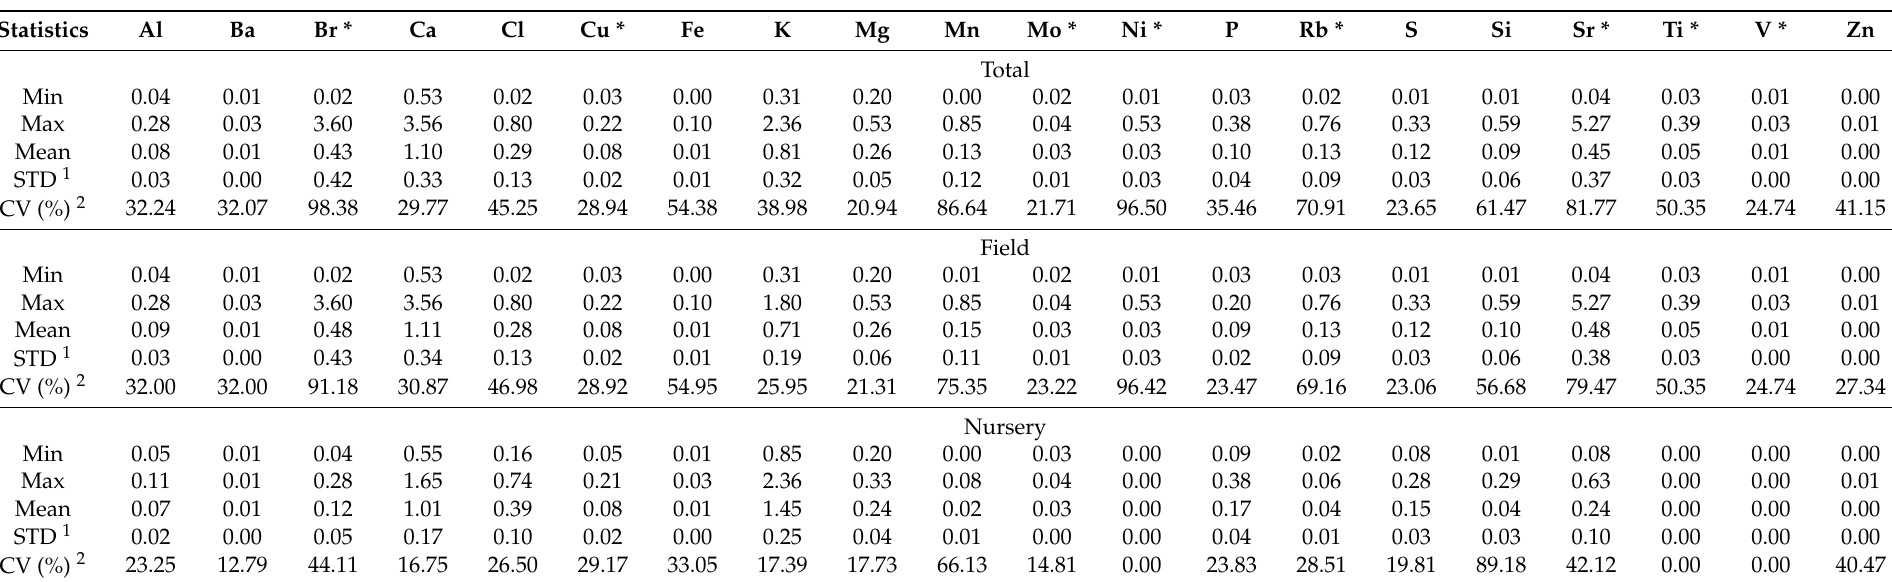
Table 2. Descriptive statistics of portable X-ray fluorescence (pXRF) elemental data (%) of Eucalyptus spp. leaves for nursery and field plants, separately and combined (total